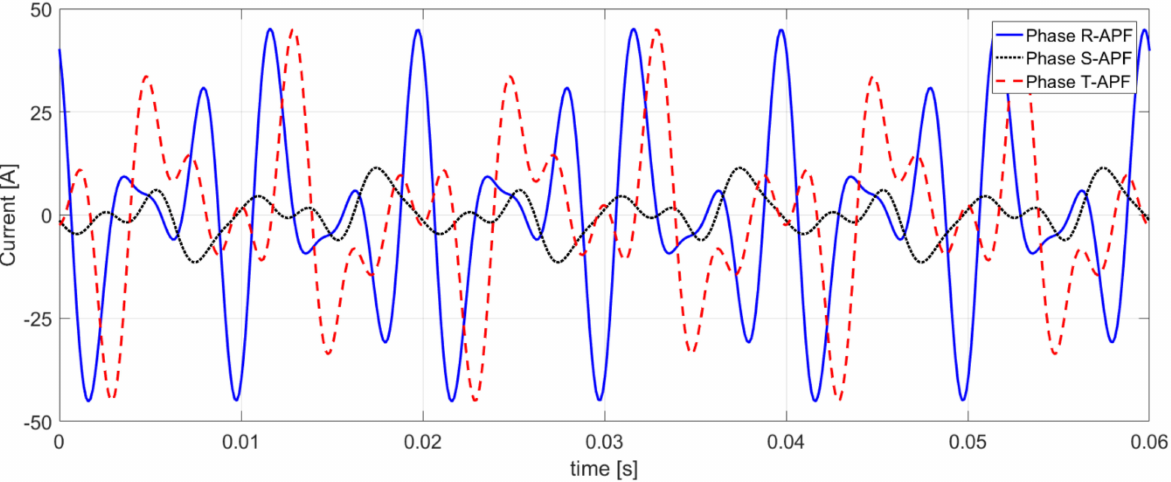
Figure 9. The waveform of three-phase referent current in cross-section X-X’—Equation